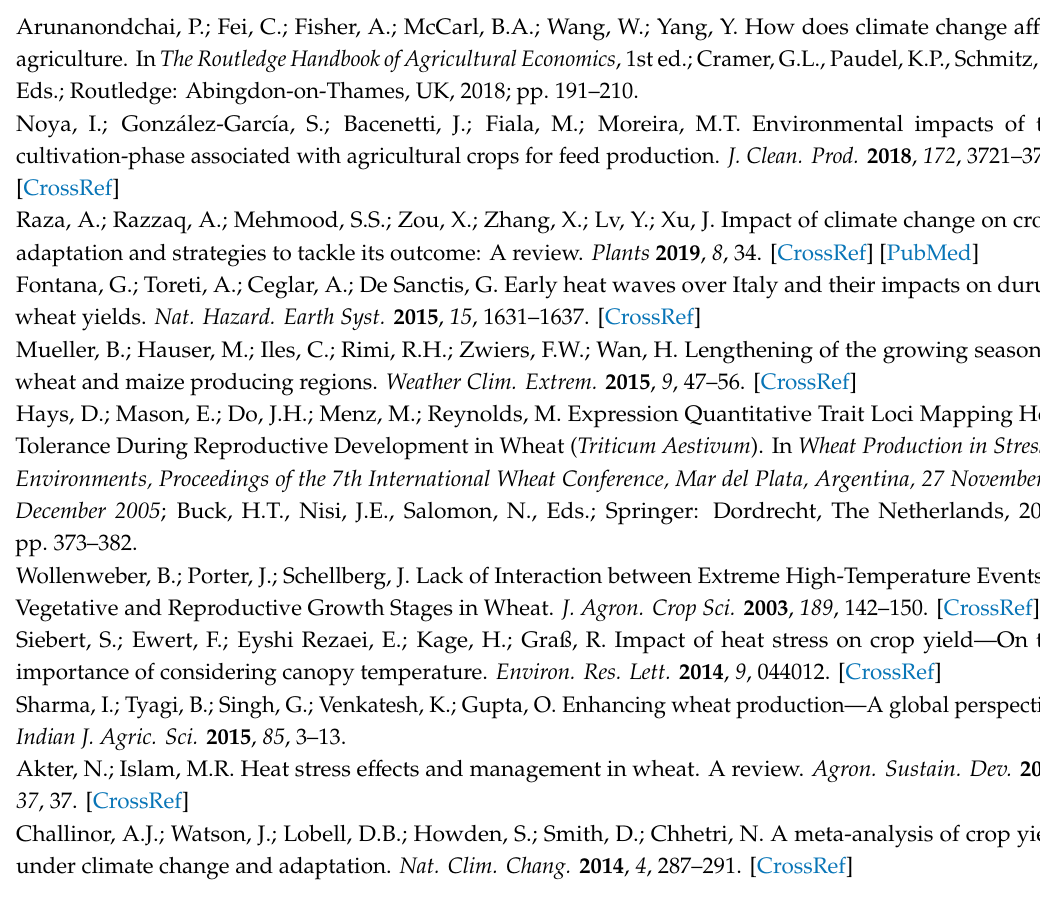
Table S1: List of genotypes, pedigree, and grouping of germplasm used in the study, Table S2: Coding Sequence ID and Protein ID of CaO, Cab, SGR, and RCCR in Brachypodium distachyon , Hordeum vulgare , Sorghum bicolor , Oryza sativa , Zea mays, and Gene ID of Triticum aestivum , Table S3: List of oligonucleotide primer sequences used for the amplification and expression analysis of the CaO, Cab, SGR, and RCCR in Triticum aestivum , Table S4: Basic statistics for the phenotypic traits measured in stay-green, moderately stay-green, moderately non-stay-green, and non-stay-green groups under control and heat stress treatments in the field experiments, Table S5: Basic statistics for the phenotypic traits measured in functional stay-green, non-functional stay-green, and non-stay-green genotypes under control and heat stress treatments in the greenhouse experiment, Table S6: Gene bank accession number for the CaO, Cab, SGR, and RCCR genes, S1: Multiple sequence alignment of CaO, Cab, SGR, and